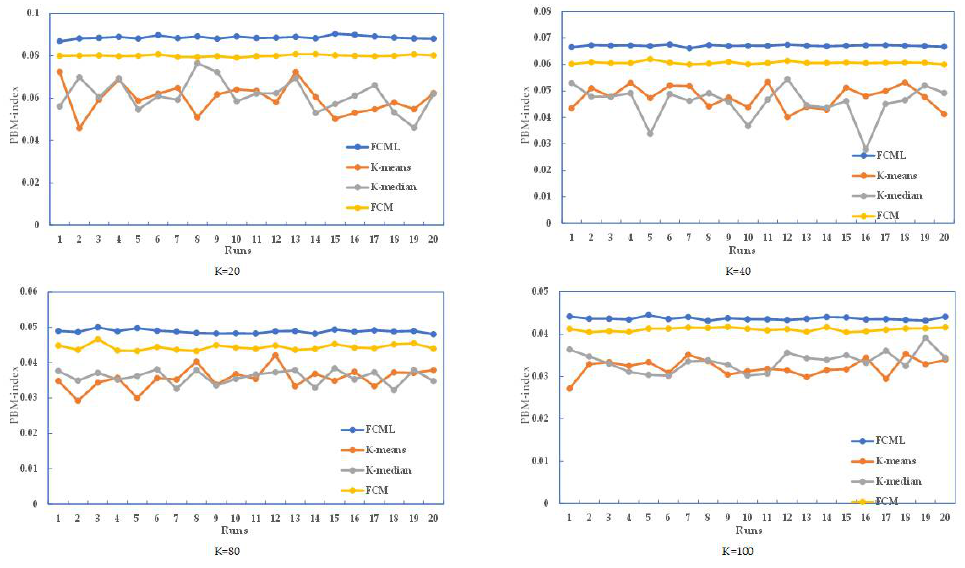
Figure 11. The PBM-index of the techniques (K-means, K-median, fuzzy C-means (FCM), and FCML) on different cluster numbers (K = 20, 40, 80, 100) for real-world taxi GPS datasets (Beijing,